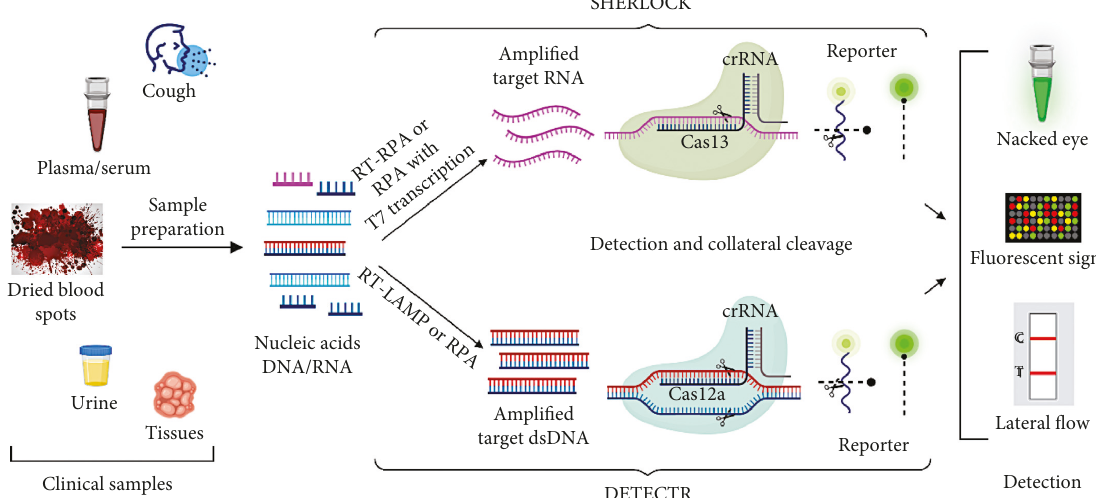
Figure 1: CRISPR-based nucleic acid detection assays employing the Cas trans-cleavage activity (SHERLOCK and DETECTR). Clinical samples after initial preparation for nucleic acid (DNA/RNA) extraction, if necessary, are treated for target amplification by isothermal preamplification. Cas nuclease remains inactive if there are no target nucleic acids in the sample. In SHERLOCK technology, target nucleic acids are isothermally amplified by recombinase polymerase amplification (RPA) or reverse-transcriptase (RT)-RPA with either DNA or RNA as input. Amplified DNA is transcribed to RNA by T7 transcription leading to subsequent target-specific activation of Cas13 from Leptotrichia sp. (LwaCas13a). Activated Cas13 forms Cas13-crRNA complex leading to on-target RNA cleavage and nonspecific collateral cleavage of off-target ssRNA reporter molecules as well. In the case of DETECTR technology, the sensitivity of target nucleic acids is amplified by RPA or RT-isothermal amplification using loop-mediated amplification (LAMP) for DNA and RNA, respectively. This amplification leads Cas12a (from Lachnospiraceae sp. (LbCas12a) or other organisms) to dsDNA targets by a complementary crRNA, resulting in the collateral damage of short ssDNA reporters. The collateral activity of Cas nucleases, in both cases, turns into detectable signals by cleavage of a quenched fluorophore containing reporter nucleotide probes added to the reaction. Quencher separation from fluorophores leads to a stable and robust fluorescent signal detected by several ways like naked eyes, lateral flow readouts, and a fluorimeter (this image was created with